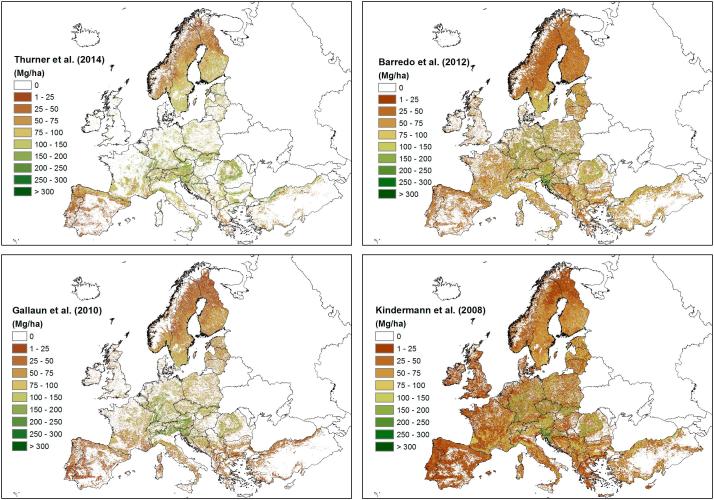
The four biomass maps for Europe: Thurner, Barredo, Kindermann and Gallaun (clockwise, from upper left).